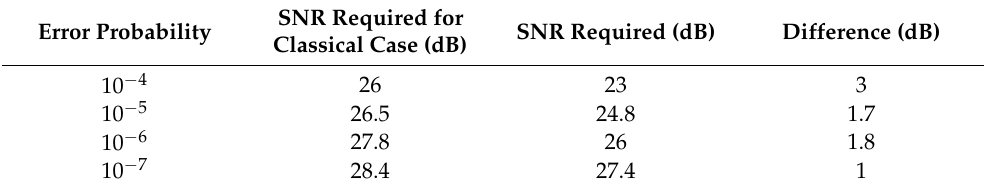
Table 3. SNR for various probabilities for a rain rate of 10 mm/h for 80